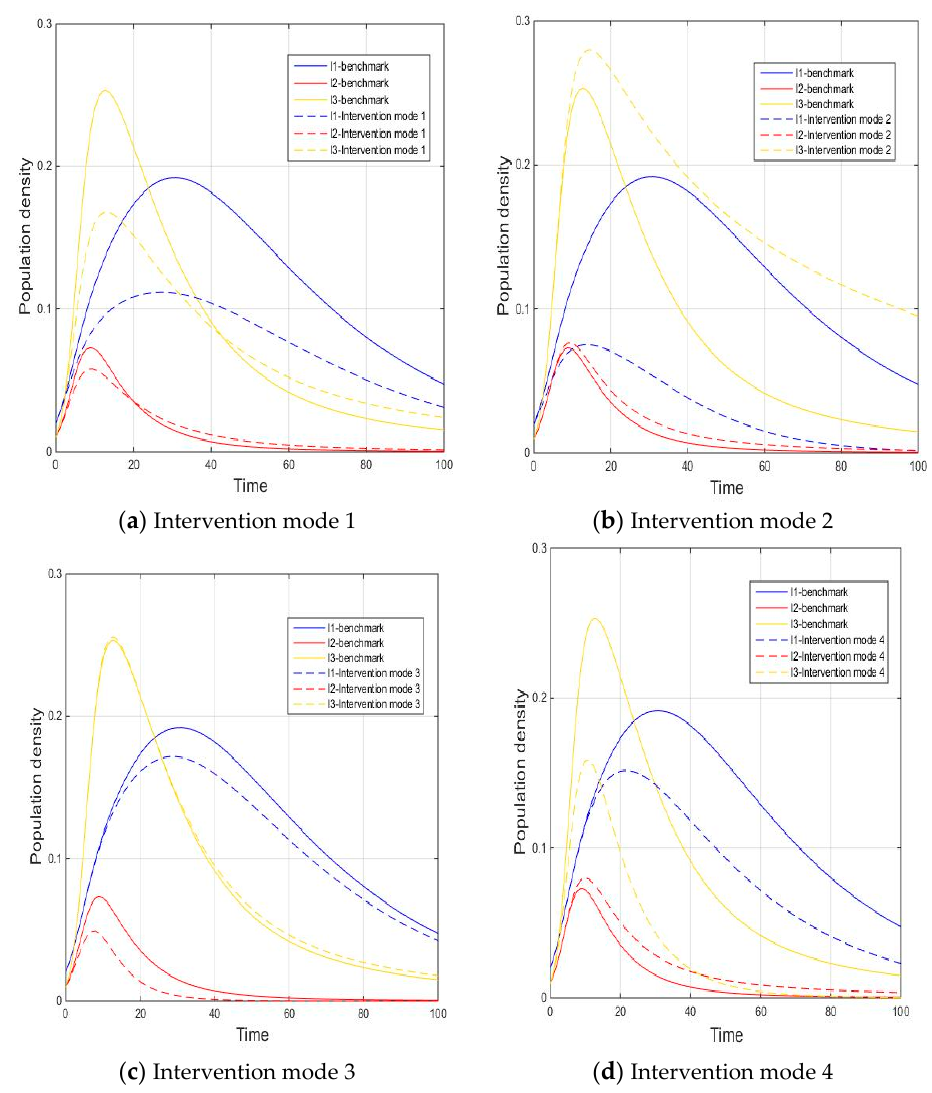
Figure 8. Impact of different intervention methods on the number of I.